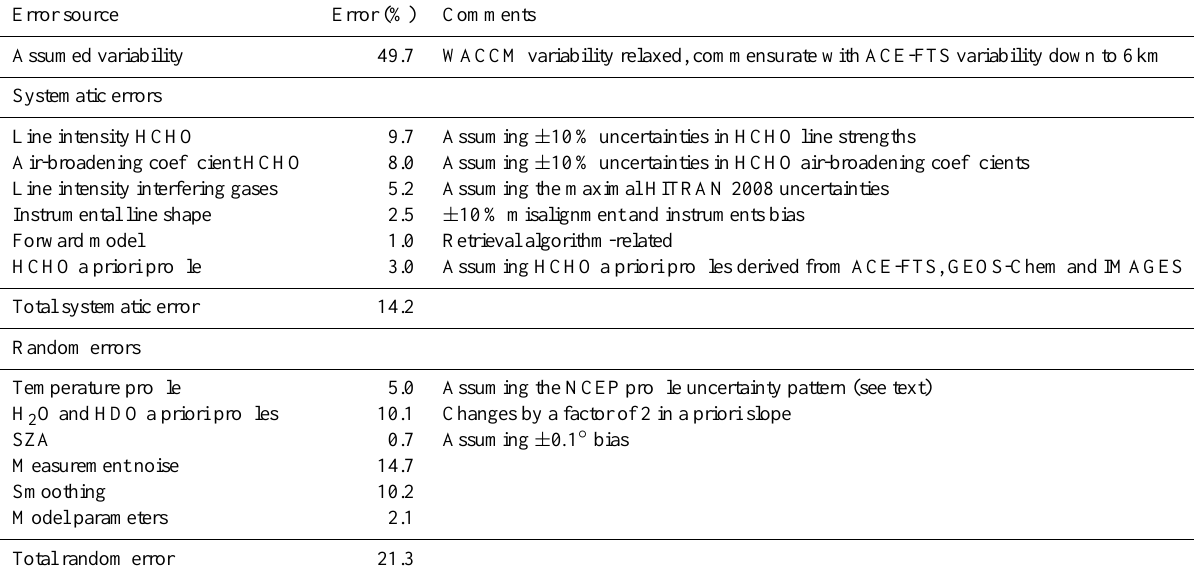
Table 2. Impact of major sources of systematic and random uncertainties on typical individual HCHO total column retrievals from FTIR solar spectra above the Jungfraujoch station. These uncertainties have been calculated on the basis of all individual solar spectra recorded during the year 2011 with the exception of the measurement noise, smoothing and model parameter contributions that have been estimated according to the OEM formalism of Rodgers (2000) on the basis of a representative subset of solar spectra.